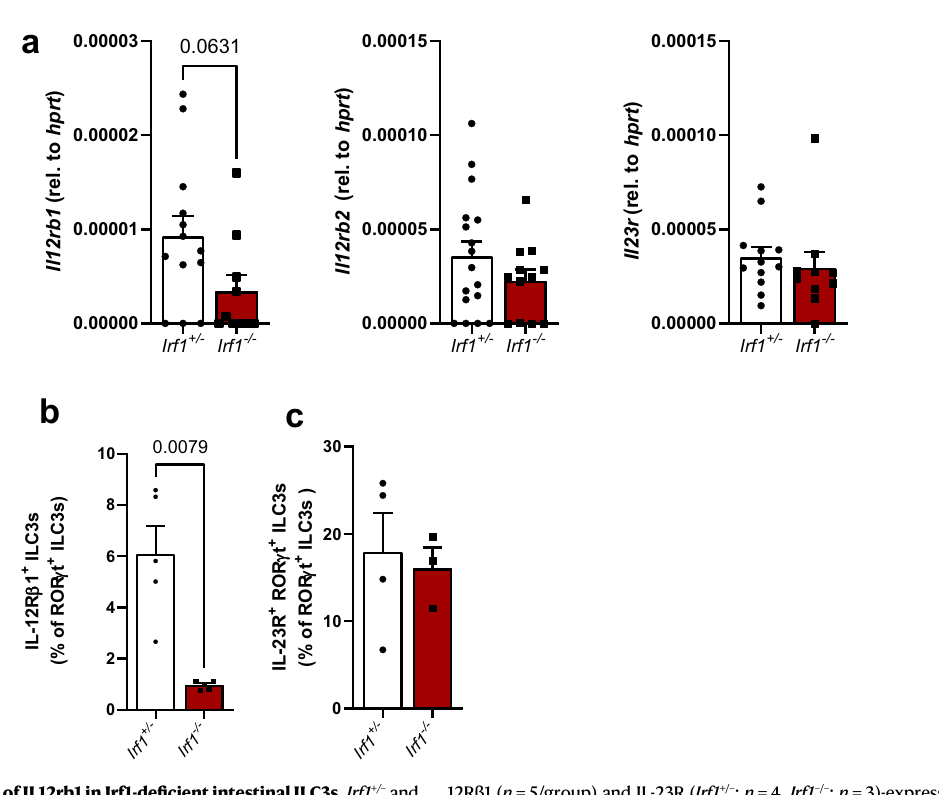
Fig.7|ReducedexpressionofIL12rb1inIrf1-de fi cientintestinalILC3s. Irf1 +/ –